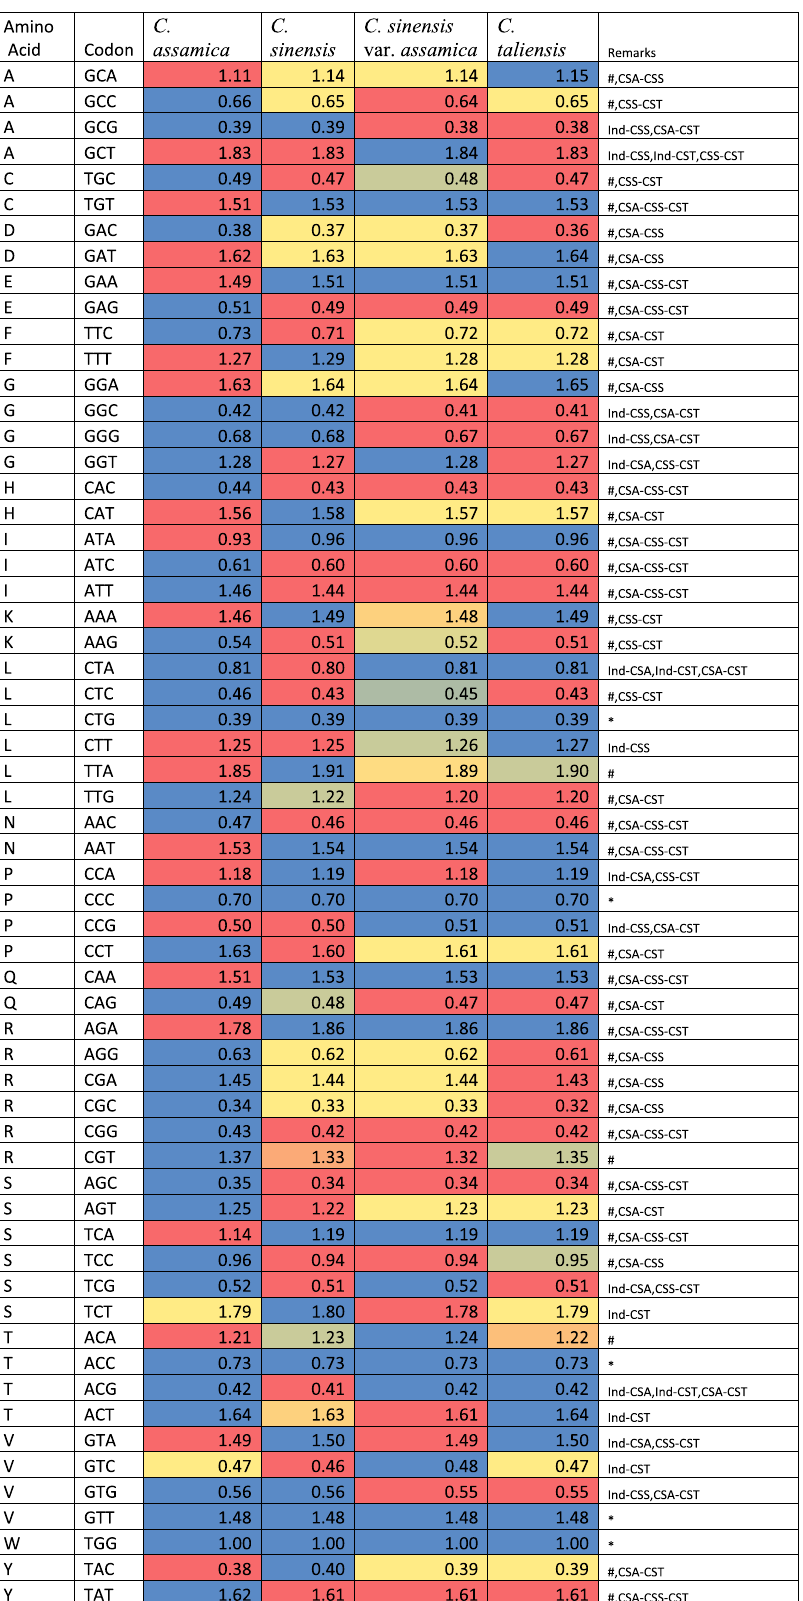
Table 2. The codon usage frequency distribution in terms of RSCU values among four cp genomes of tea with colour coded for blue–yellow–red scale for maximum to minimum